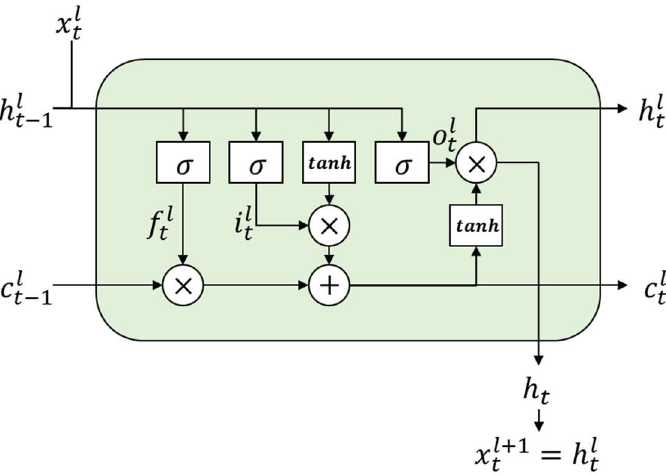
Figure 2. Cell structure of